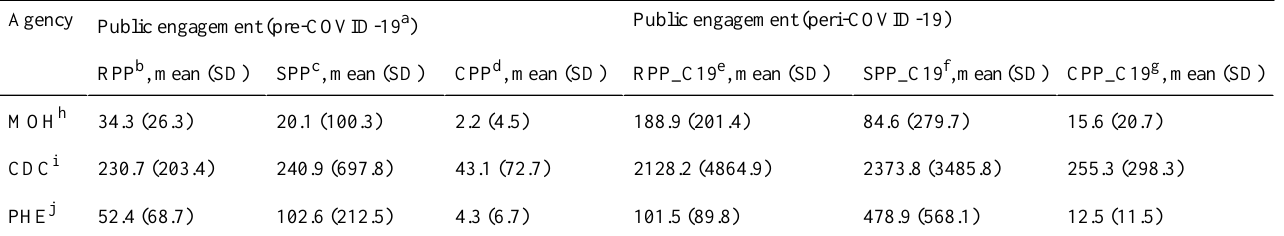
Table 2. Summary of COVID-19 Facebook engagement by the MOH, the CDC, and PHE during the periods of pre-COVID-19 (January 1, 2019, to